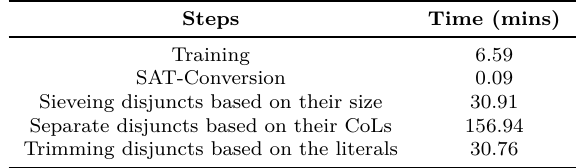
Table 8: Execution time of each steps of TTSCA big on ASCADv1_f.